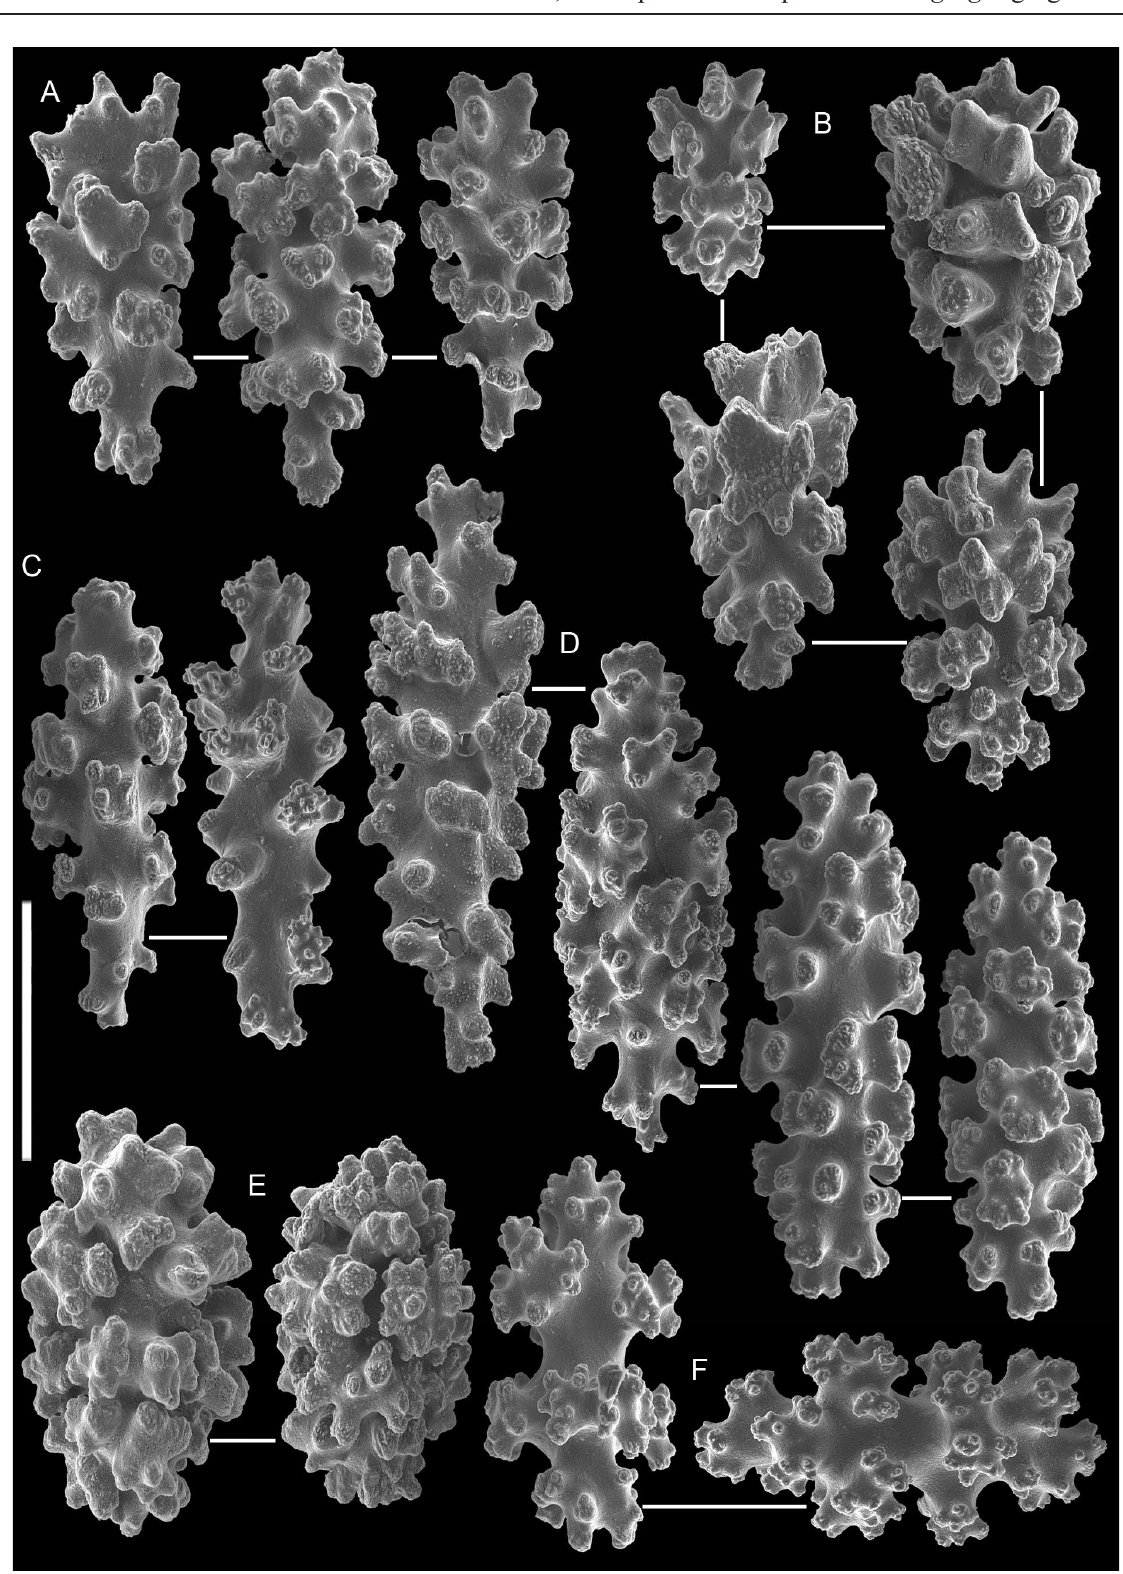
Fig. 3. Calcigorgia herba sp. nov., holotype MIMB 20744, sclerites from the polyp body wall. A . Warty clubs. B . Poorly developed clubs with leafy processes. C . Club-like spindles. D . Plump spindles with well-developed warts. E . Ovals. F . Capstans (8-radiate) with girdled warts. Scale bar = 0.1